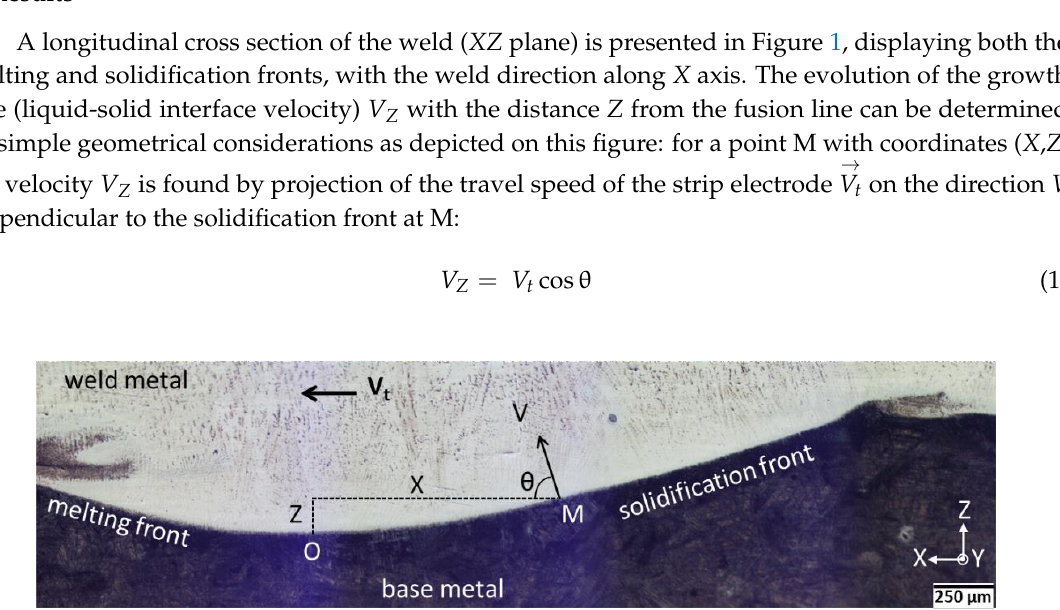
Table 3. Growth rate V Z at several distances Z from fusion line.